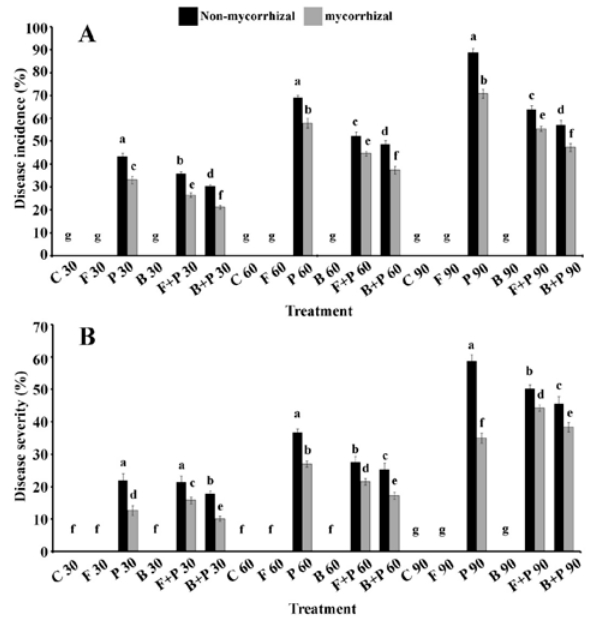
Figure 3. Mean disease incidence (A) and severity (B) of garlic plants in response to the tested treatments. C = untreated con- trol, F = treated with tebuconazole, P = inoculated with Sclerotium cepivorum , B = inoculated with Bacillus amyloliquefaciens GGA, F+P = treated with tebuconazole and inoculated, and B+P = inocu- lated with S. cepivorum and treated with the bacteria, at three plant growth stages (30, 60, or 90 days post inoculation). At each growth stage, columns accompanied by the same letter are not significantly different ( P =0.05) according to Duncan’s multiple range